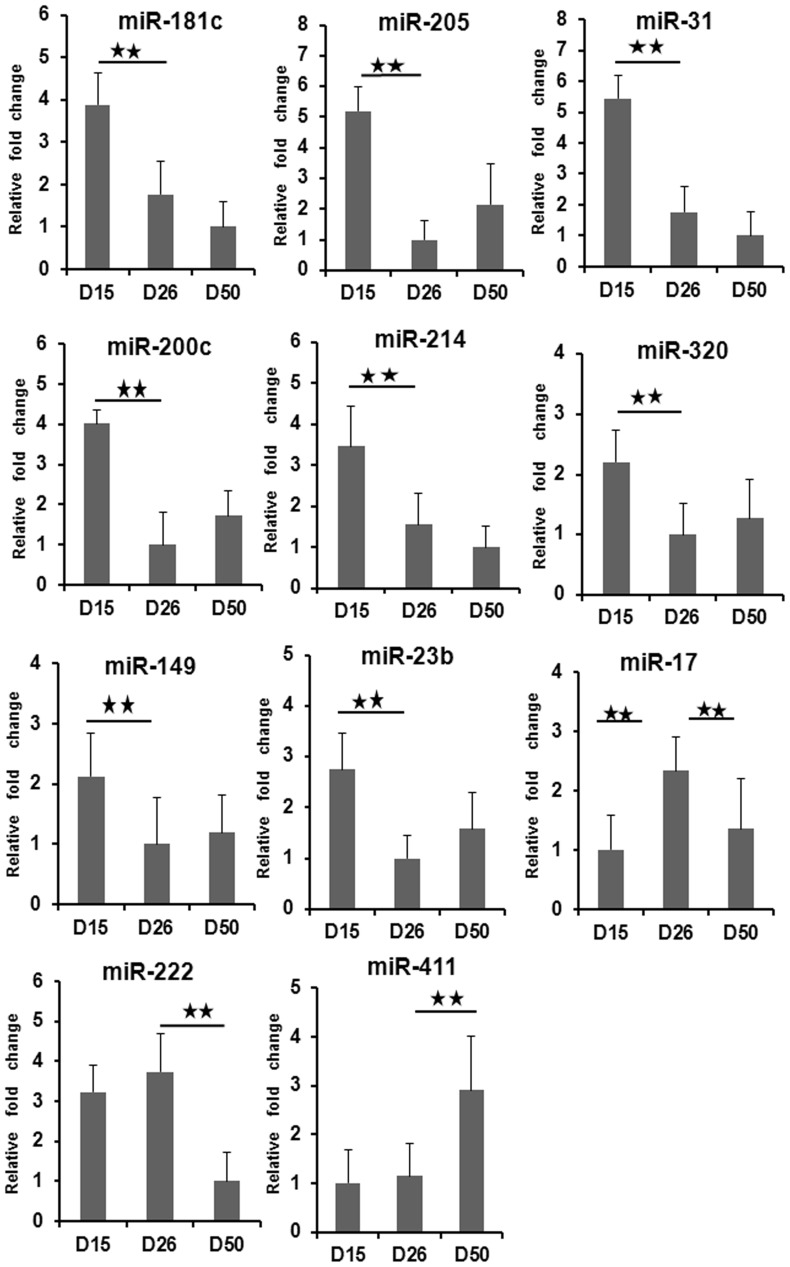
Validation of differentially expressed miRNAs by qPCR.All samples were normalized to RNU6. The error bars show the SEM. The significance of differences for miRNA expression was calculated using two-tailed T-test. *, p<0.05; **, p<0.01. D15: gestational day 15; D26: gestational day 26; D50: gestational day 50.